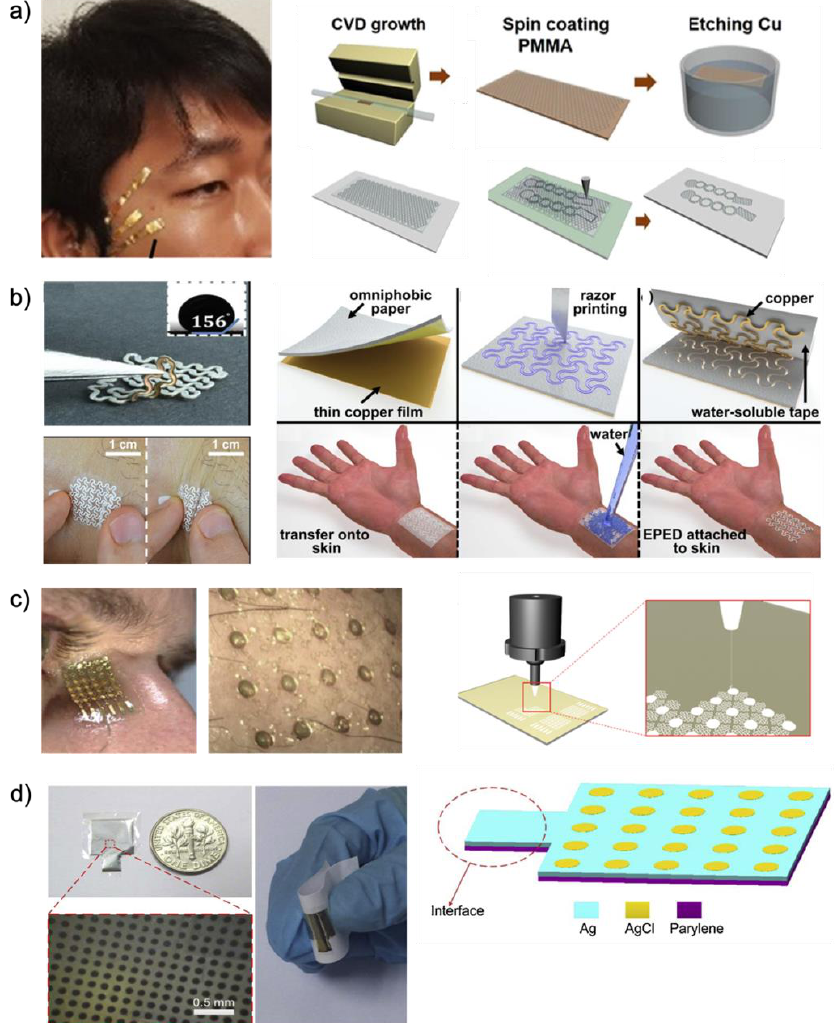
Figure 4. Schematic diagrams and images of micro-patterned electrodes: ( a ) Graphene electrode fabrication process based on a polymer material (reprinted under terms of the CC-BY license [11].